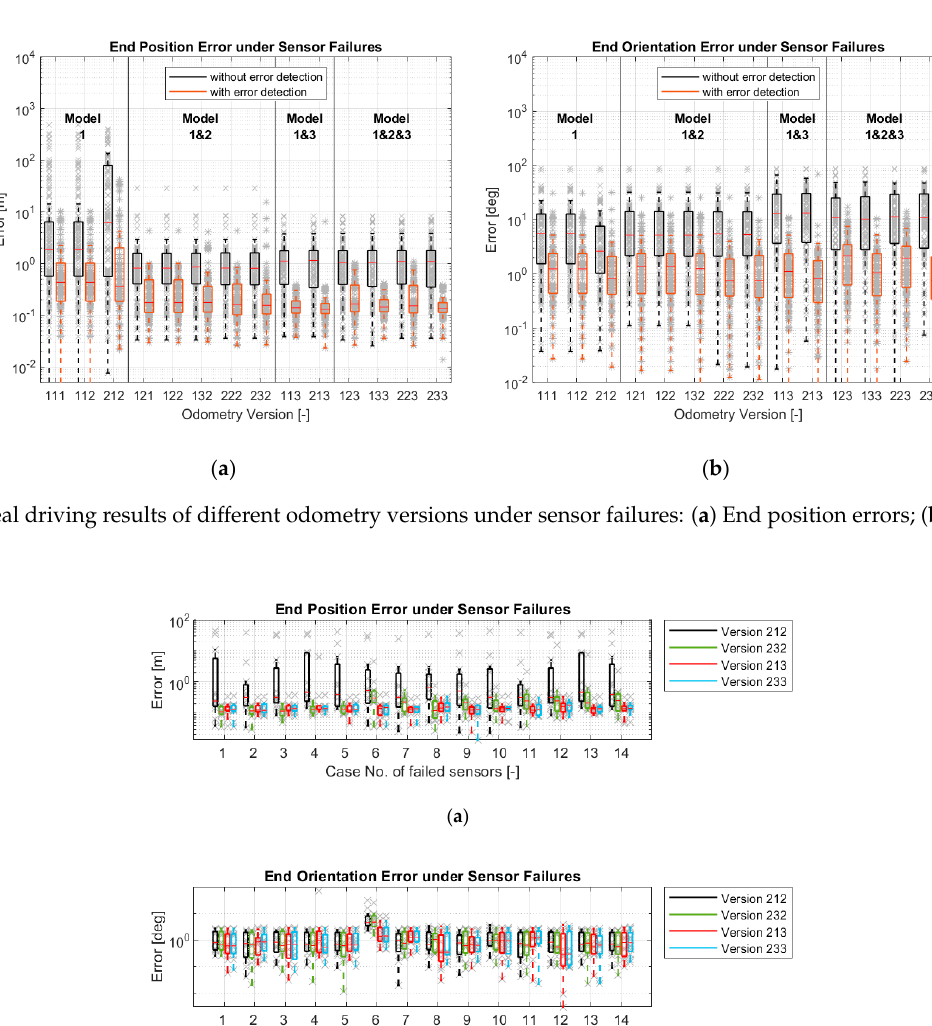
Figure 25. Real driving results of different odometry versions using a yaw rate sensor with a resolution of 0.01°/s: ( a ) End position errors; ( b ) End orientation errors.